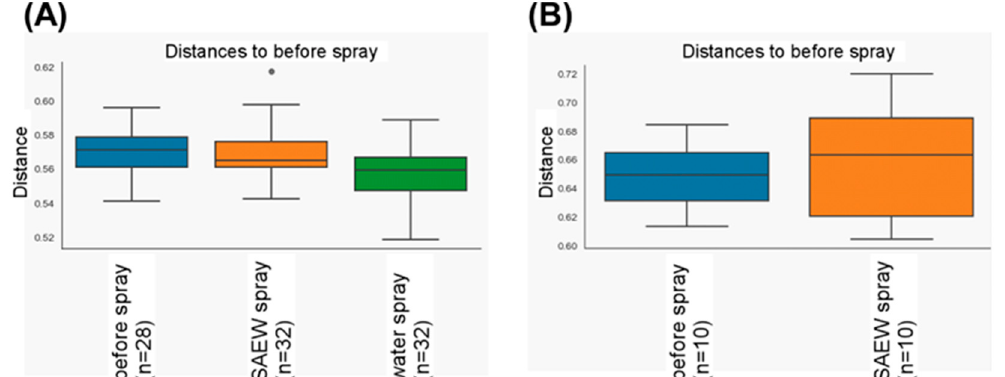
Figure 7. Box plot of beta diversity of bacteria in the greenhouse. The box plot represented (A) the values of the distances to the soil bacterial community before spraying SAEW and tap water, and (B) the values of the distances to the eggplant leaf bacterial community before spraying SAEW and tap water, based on UniFrac distances. The box plots show medians (horizontal line in box), 25 and 75% quartiles, and max/min values, outliers marked as circles.